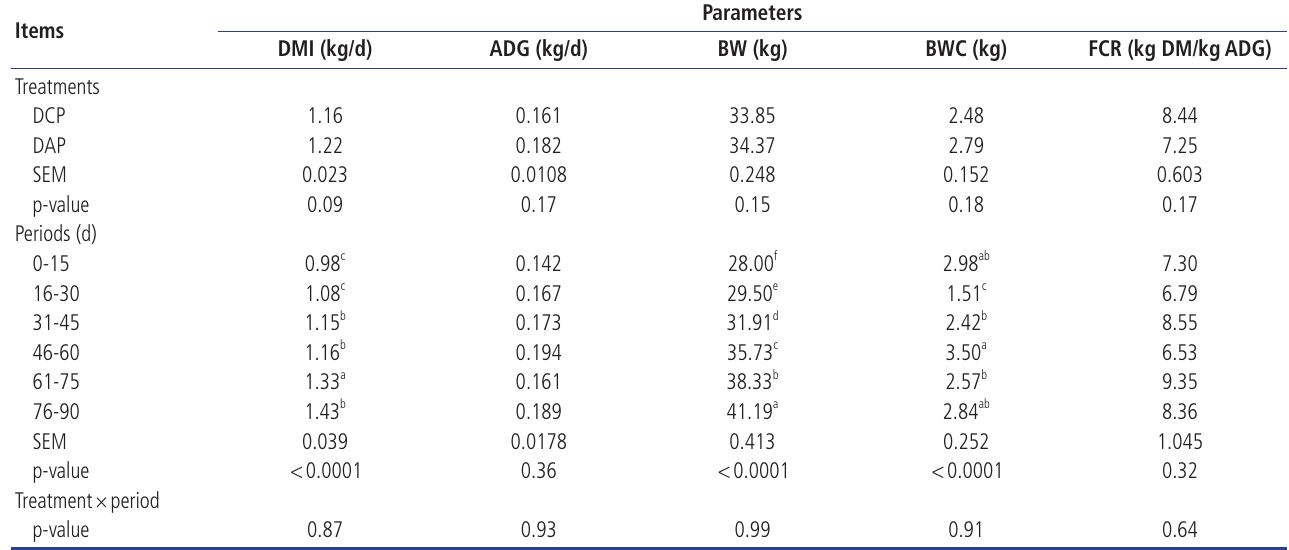
Table 3. Dry matter intake (DMI) and performance of finishing lambs fed a diet supplemented with either di-calcium phosphate (DCP) or di-ammonium phosphate (DAP) as the phosphorous source during a 93 day period Items Treatments